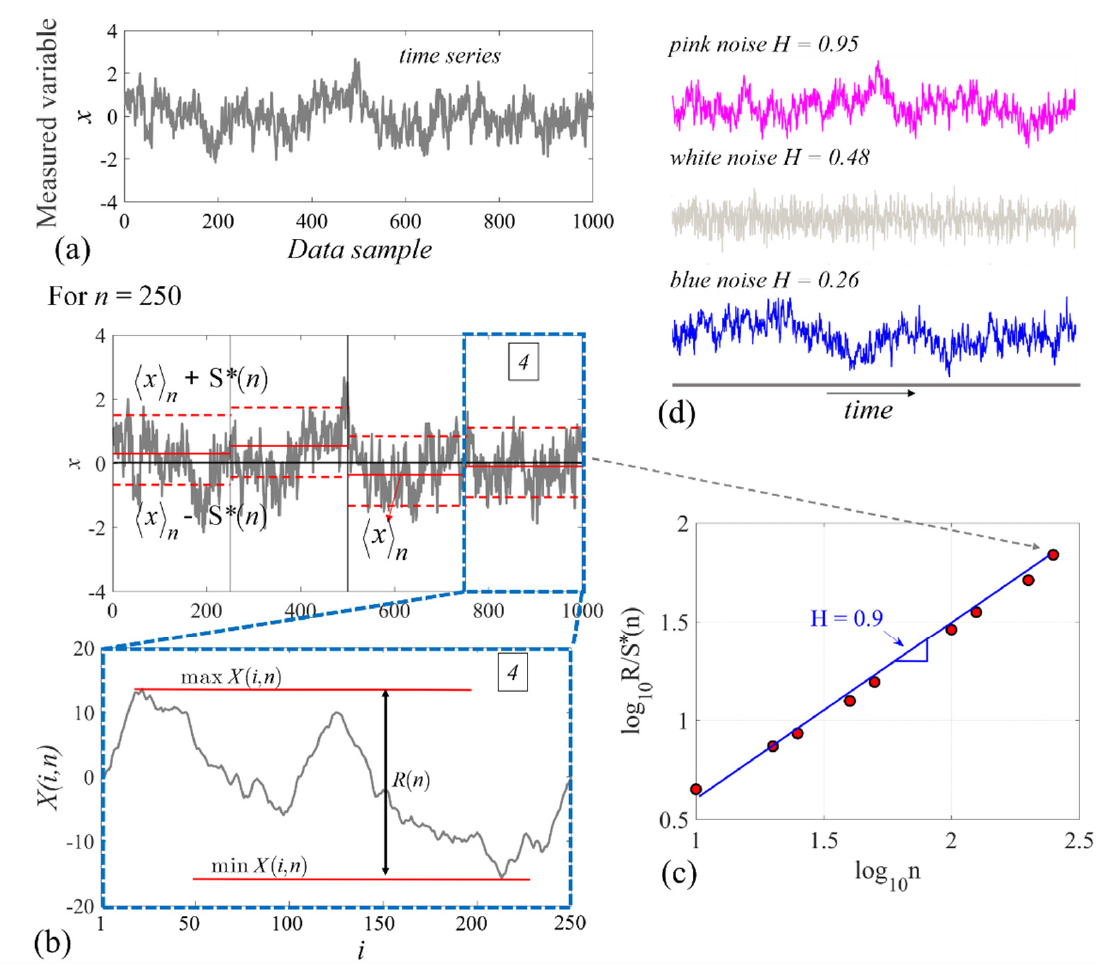
Figure 3. Basic parameters involved in standard R /S* analysis: ( a ) a non-stationary time series x ( i ) ; ( b ) Example of Hurst exponent considering n = 250, where (cid:104) x (cid:105) is the mean and S ( n ) the standard deviation, X ( i , n ) are the local differences accumulated from the mean, and R ( n ) is the local range, that is, the difference between maximum and minimum X ( i , n ) (adapted from [42]); ( c ) log-log plot of the rescaled range R /S* versus window size n . The estimated scaling exponent H is the slope of the least-squares fitting line; ( d ) representative examples of H value for a white (random), pink (fractal, long-range correlated, slightly persistent), and blue (anti- persistent) time series.